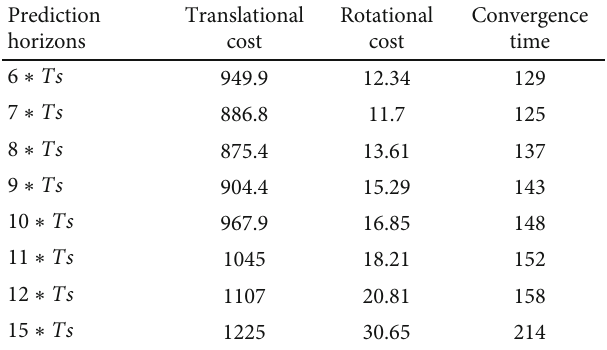
Figure 8: Time histories for the translational and rotational velocities in the body fi xed frame. Table 4: Cost comparison according to the prediction horizons.